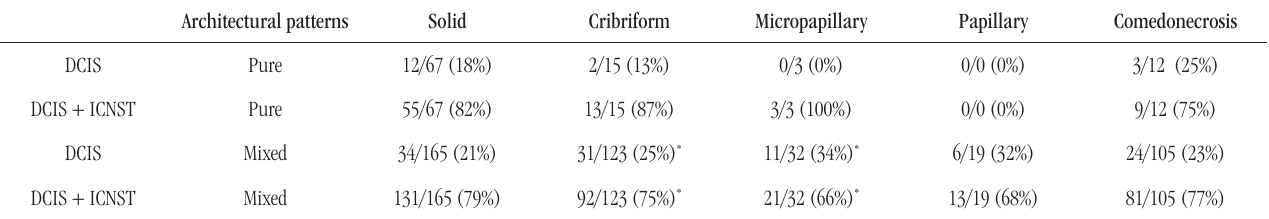
table 1 – Correlation of the different pure and mixed architectural patterns of DCIS in the groups DCIS and DCIS associated with ICNST – number/total (%) Architectural